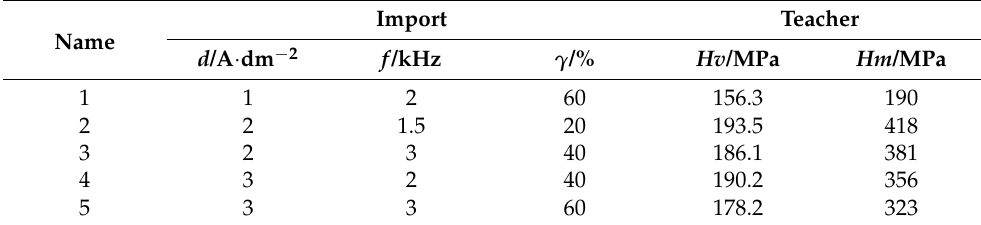
Table 3. Partial sample.